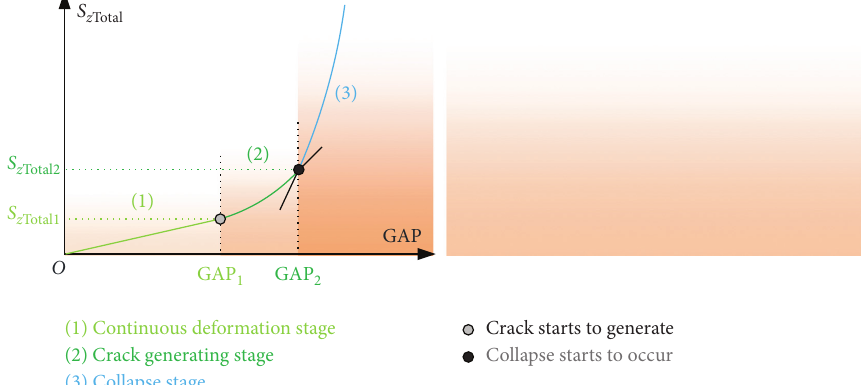
Figure 5: Ground displacements against GAP parameter (evolution of ground collapse).